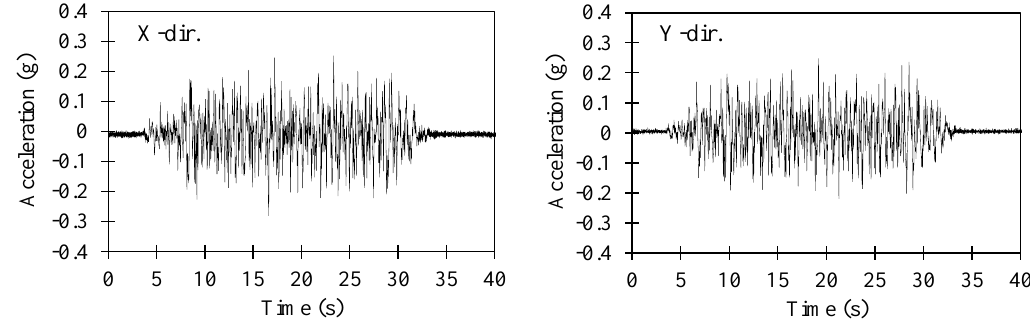
Figure 6. Input acceleration time history in the X and Y-directions for AC156_100.